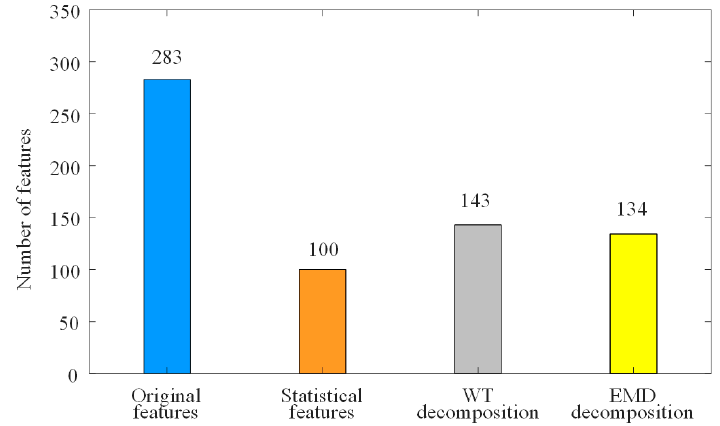
Figure 11. Statistical results of the valid features. The statistical results of the subdivided valid features are shown in Figure 12.